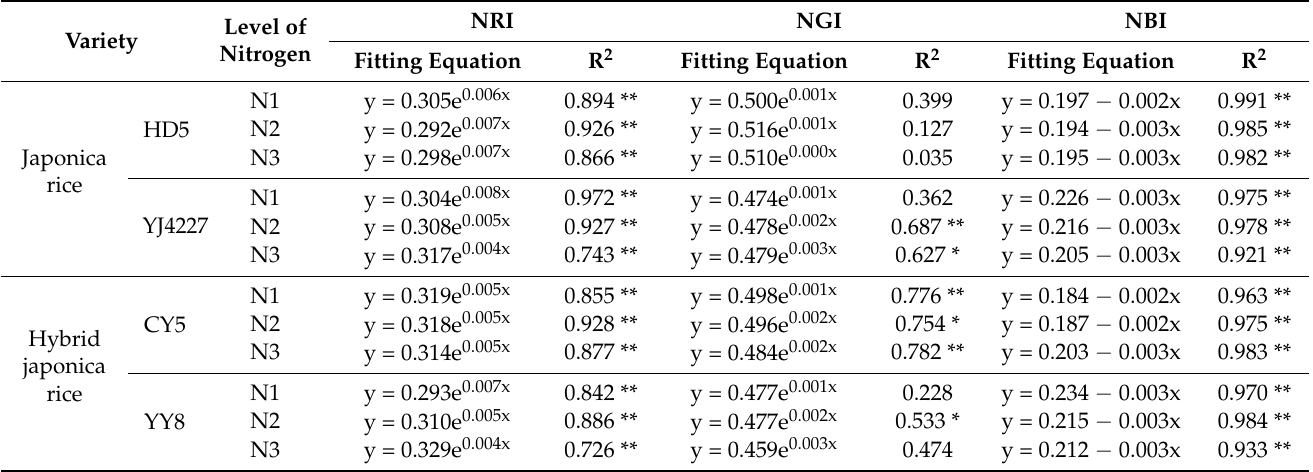
supply levels (y = ae bx , y = a +